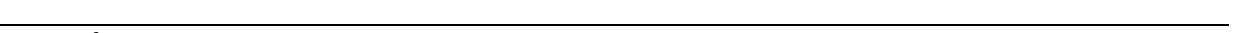
Fig. 8 In vivo Ca 2 + imaging of spinal dorsal horn neurons. a A scheme of experimental setup. Two-photon imaging of SDH was performed through custom built implanted imaging chamber and electrode was inserted into one side of ACC after a small craniotomy. Pinching and brushing were applied to the contralateral hindpaw. b – c Representative image showing the Ca 2 + responses before and after pinching/brushing and ACC stimuli. Raw fl uorescent intensity was pseudo-colored and region of interests were numbered. Changes of intensity were plotted under the images and corresponding time points to images were indicated by open arrow head (Pinching/Brushing) and closed arrow head (basal). Roi 1, 2, 6 in b and Roi 1, 2, 4 in c were identi fi ed neurons with potentiated responses to ACC stimulation; Roi 3 or Roi 4, 5 in b were neurons with alleviated or no changed responses. Roi 3, 4, 6 – 8 in c have no responses to brushing. d Maximal Ca 2 + response to brushing and pinching in each cells indicated as Δ F t / F 0 were plotted at pre-ACC and post-ACC stimulation. Data were separately plotted on the basis of the effect of ACC stimulation (increase or decrease). e Summarized results of identi fi ed